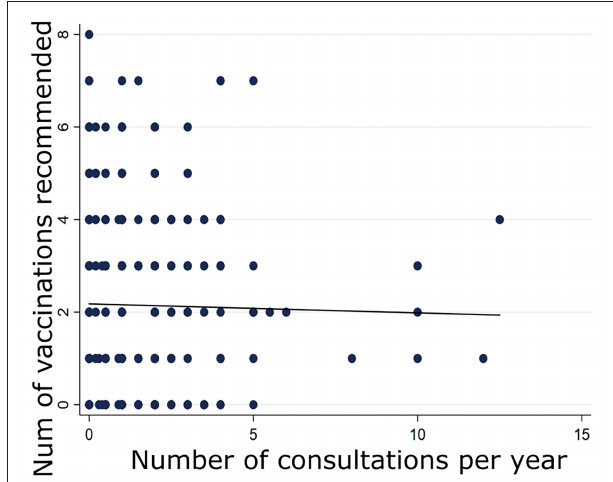
FIGURE 2 | Correlation between the number of vaccinations recommended to participants and the frequency of their medical consultations ( n =